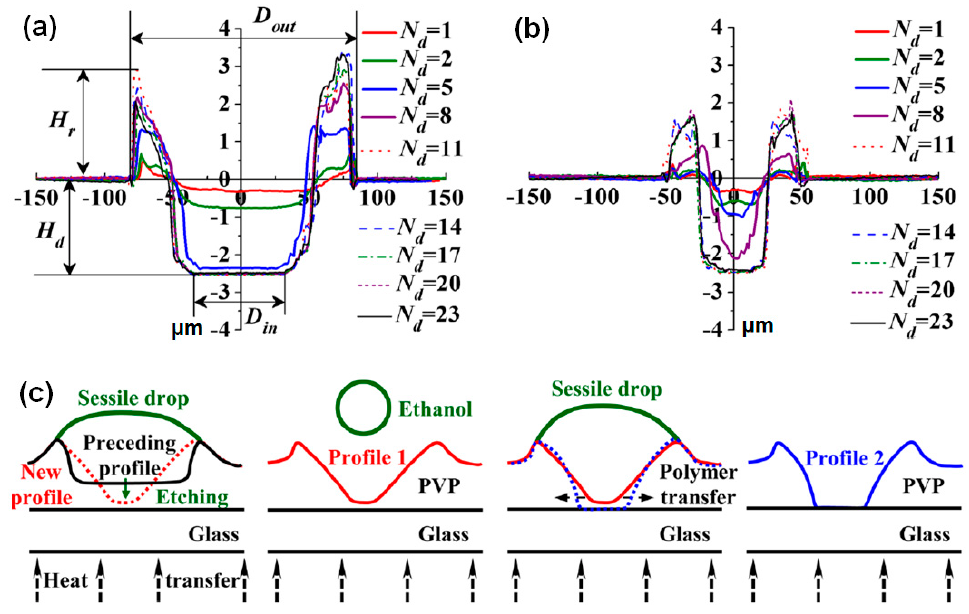
Figure 3. ( a ) Surface profiles obtained after dropping 1 to 23 droplets of ethanol onto poly(4-vinylphenol) (PVP) on a substrate with a temperature of 20 °C. ( b ) Surface profiles of PVP after dropping 1 to 23 droplets of ethanol onto PVP on a substrate at a temperature of 80 °C . ( c ) Schematic diagram of the formation of a hole resulting from the dropping of successive ethanol droplets at a high substrate temperature [40]. Copyright 2013 American Institute of Physics.